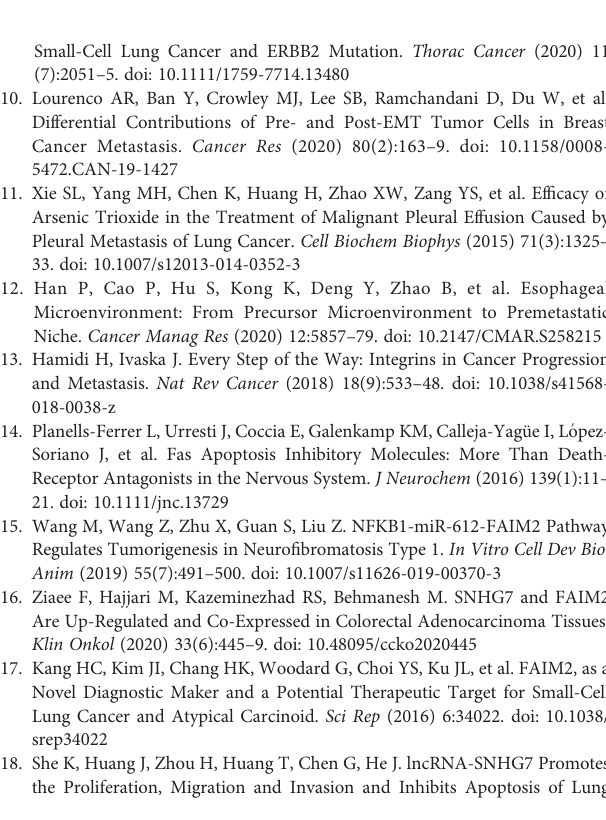
Supplementary Figure 1 | Primary OB and MC3T3E1 cells were effective for inducing osteoblast differentiation. Following the induction of osteoblast differentiation, (A) the levels of ALP and RUNX2 protein and mRNA expression in cells were measured by qRT-PCR and western blotting. (B) ALP staining and Alizarin Red staining were performed to evaluate osteoblast formation. P * 0.05, *; P < 0.01, ** vs. Control group. Supplementary Figure 2 | HARA-B4 cells showed a stronger adhesive ability to osteocytes than did HARA cells HARA and HARA-B4 cells that had been transfected with the GFP plasmid were co-cultured with NIH3T3, Primary OB or MC3T3E1 cells. (A – C) The adhesive ability of HARA and HARA-B4 cells was measured. NS: not signi fi cant. P < 0.01, ** vs. HARA